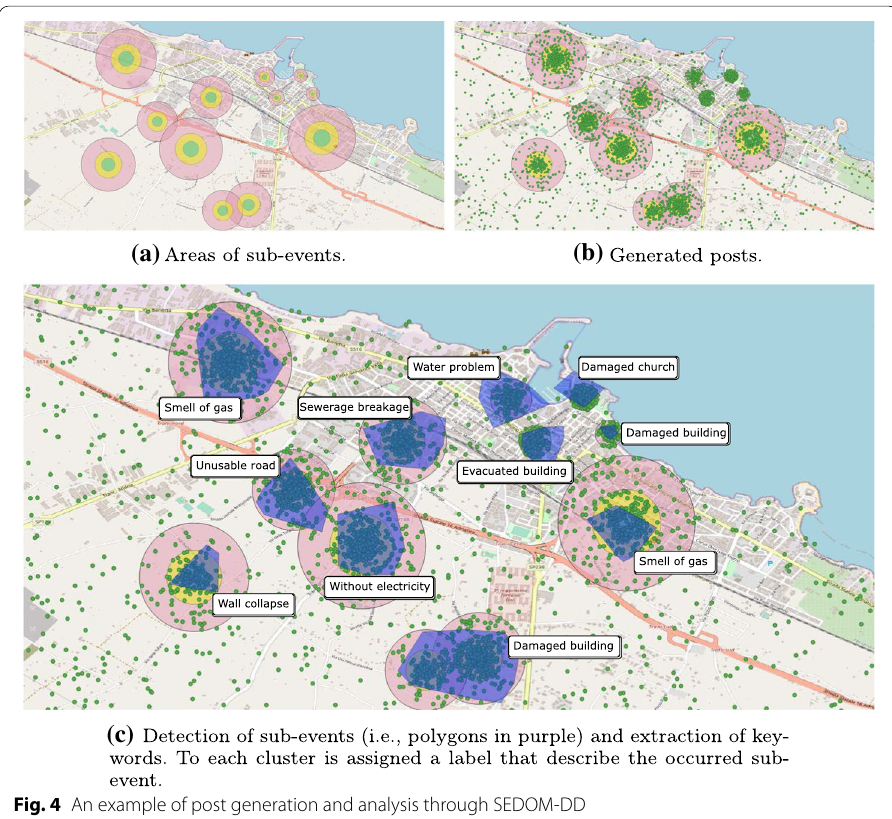
Fig. 4 An example of post generation and analysis through SEDOM-DD